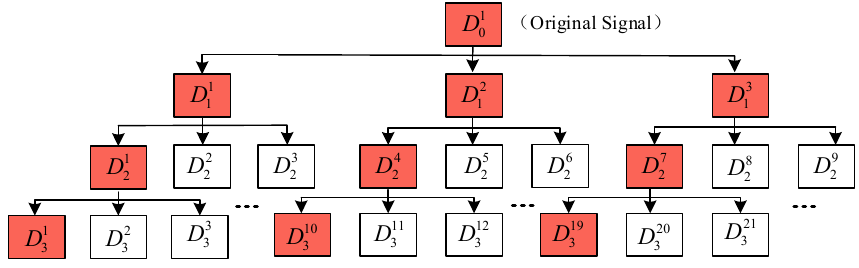
Figure 2. Schematic diagram of ESVDP and FESVDP (the red